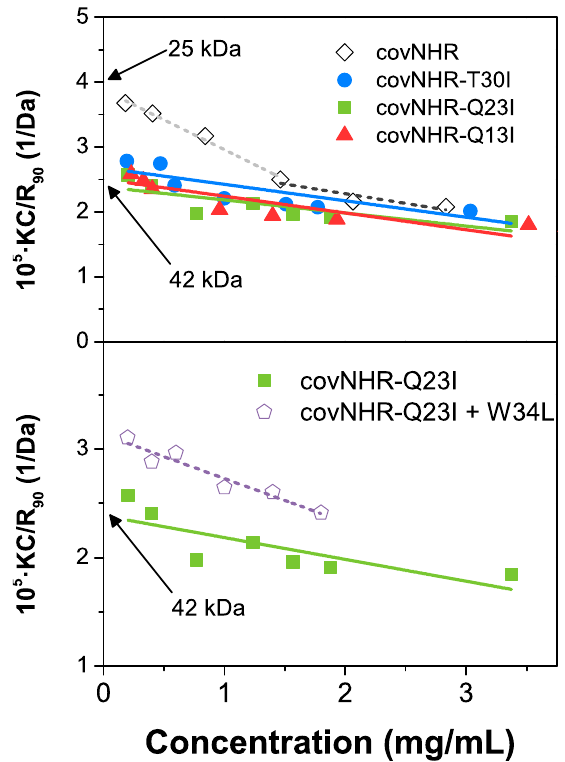
Figure 5. Molecular size of the covNHR proteins. Upper panel: Debye plots corresponding to the scattering intensities of protein solutions at different concentrations for the covNHR reference protein and the triple mutants. The intercepts of the linear tendencies indicate the weight averaged molar mass of the molecules. Bottom: Debye plots corresponding to the covNHR-Q23I mutant in its free form and in complex with the W34L peptide.